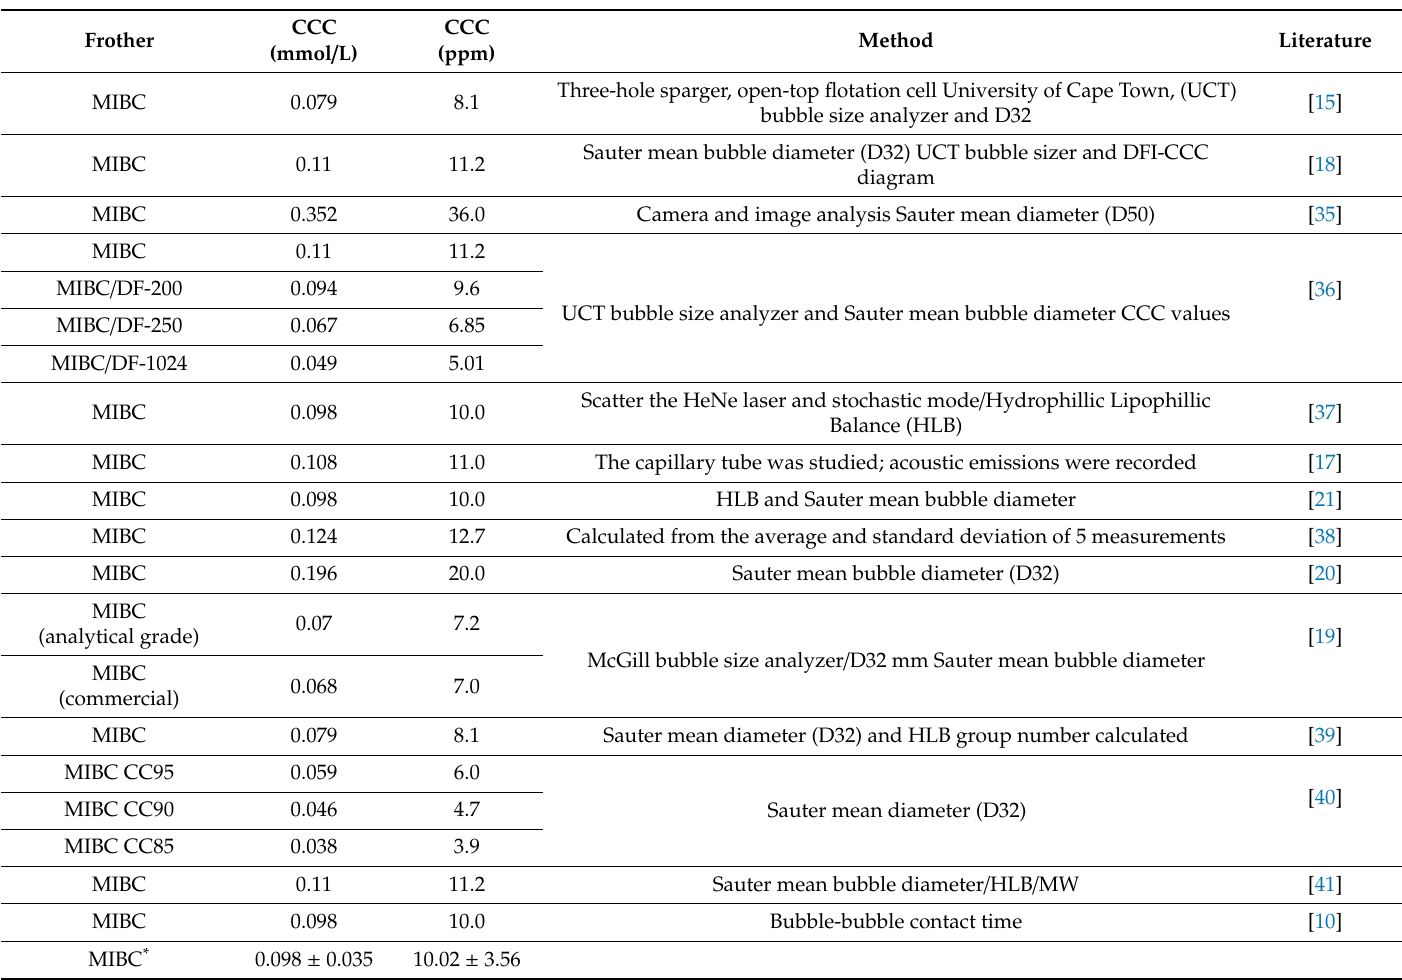
Table 4. Determination of CCC values for MIBC using di ff erent